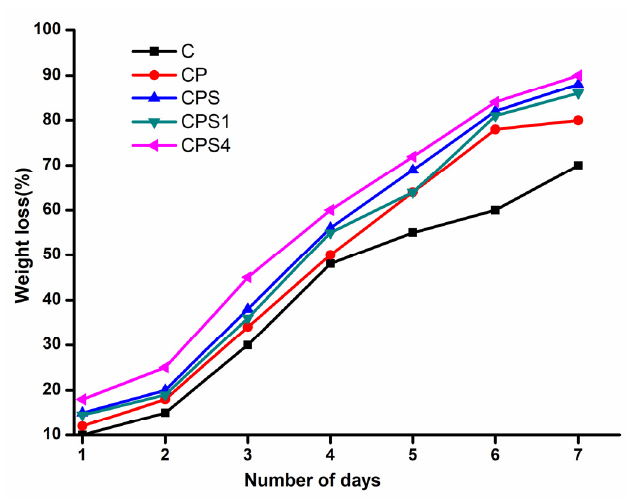
Figure 8. Soil biodegradability of CH scaffolds at different intervals of days.